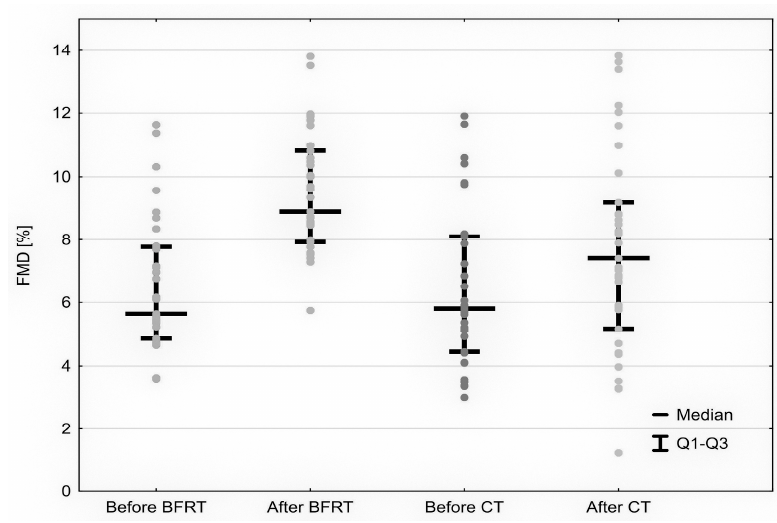
Figure 2. Comparison of FMD changes between participants after BFRE and control training.